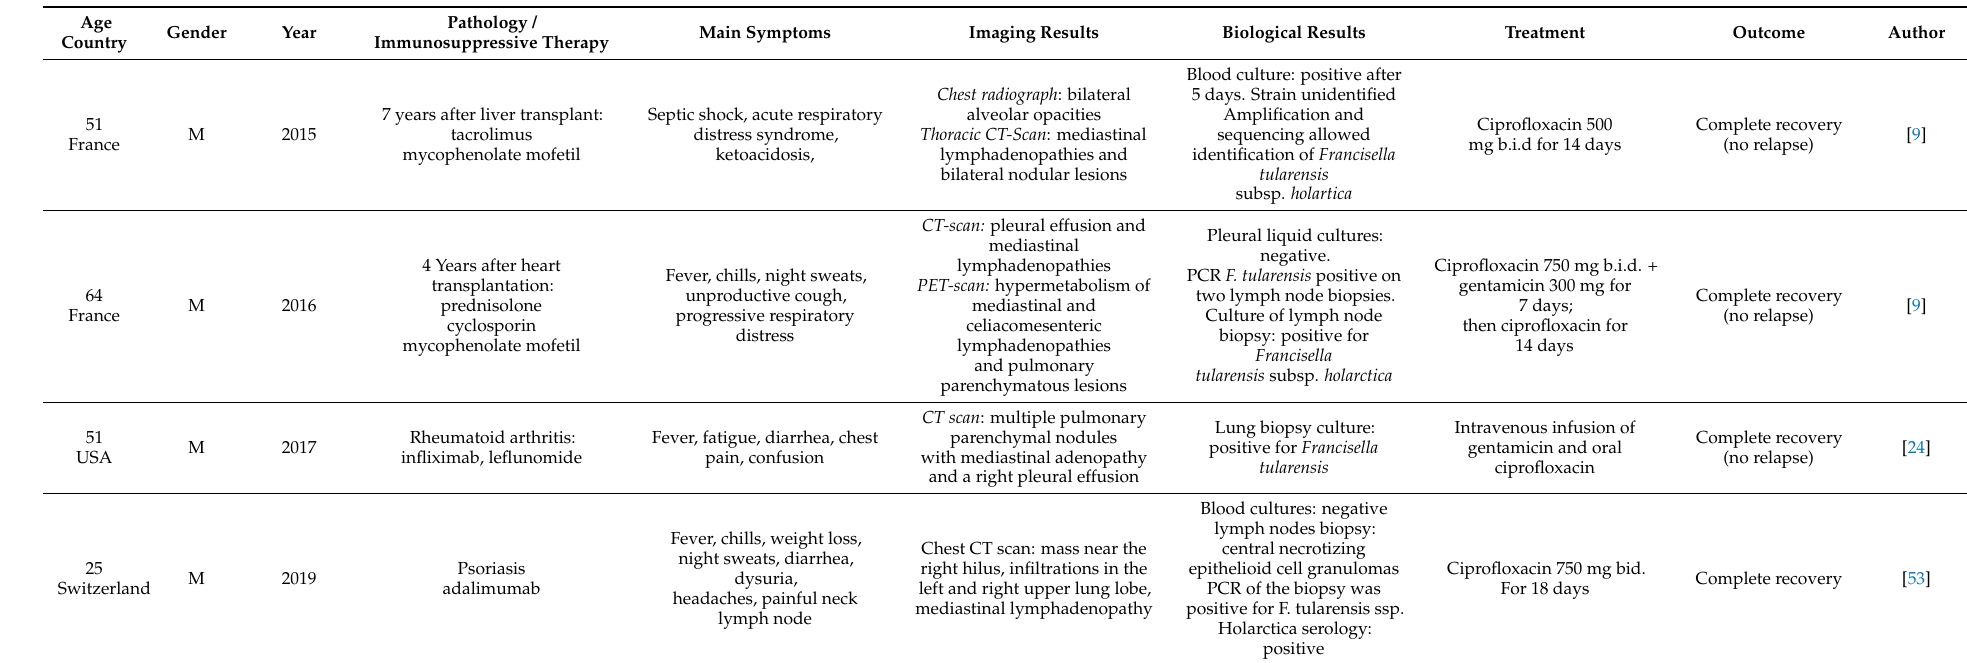
Blood cultures: negative lymph nodes biopsy: central necrotizing epithelioid cell granulomas PCR of the biopsy was positive for F. tularensis